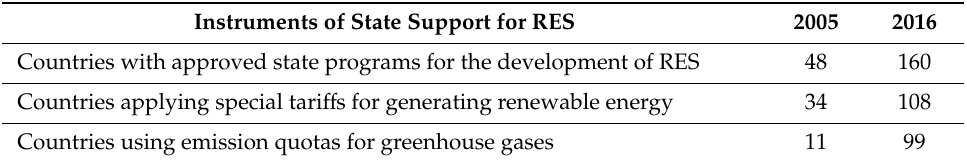
Table 1. Application of state support mechanisms for renewable energy sources (RES) in the